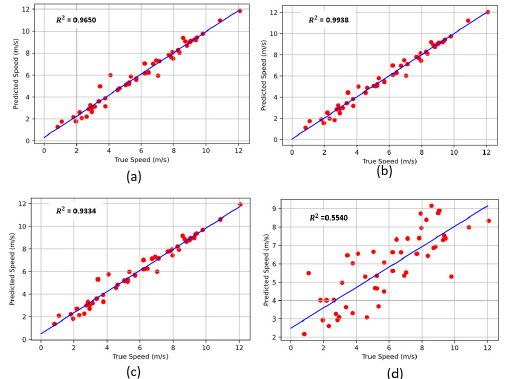
Figure 12. Correlation plots between measured and predicted wind speeds for 1 hour ahead prediction for Cases 2-5. (a) Case 2 (b) Case 3, (c) Case 4, (d) Case 5